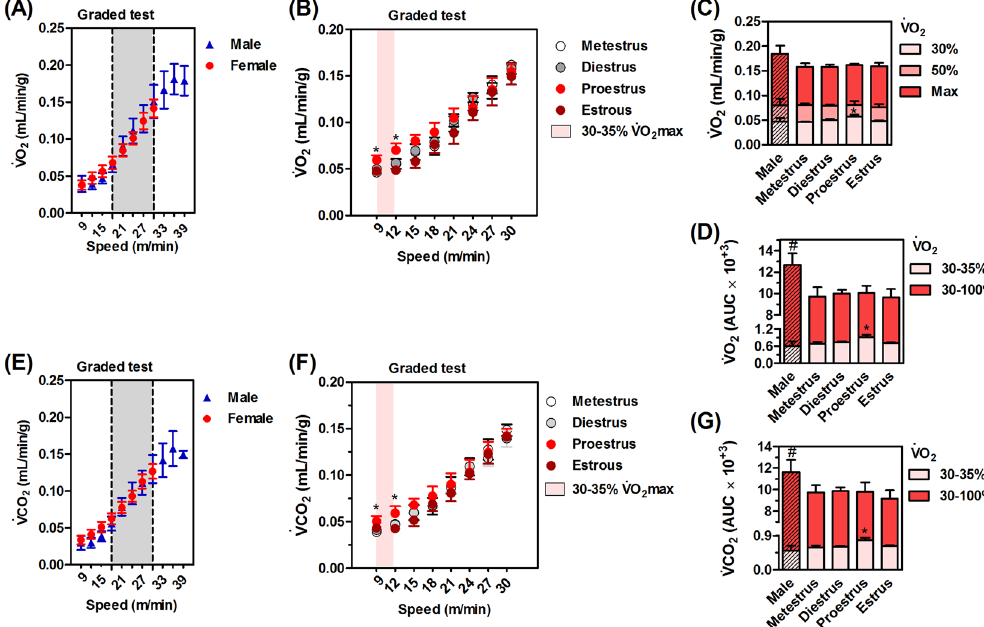
Figure 3. Respiratory gases during an incremental test. Running similarly increased general O 2 consumption ( V  O 2 , A , B ) and CO 2 production (  V CO 2 , E , F ) in males and females at different speeds up to 33 m/min. V  O 2max was similar between the sexes ( C ) total  V O 2 ( D ) and V  CO 2 ( G ) was only higher in males due to higher running speeds. Proestrus increased submaximal  V O 2 ( B and D ) and  V CO 2 ( G ) at lighter intensities of ergospirometry (30–35%  V O 2max ). Values are expressed as mean ± standard error of mean (SEM). N = 8–10 animals/group. * P < 0.05 vs . male, # P < 0.05 vs . females (ANOVA, Bonferroni post hoc